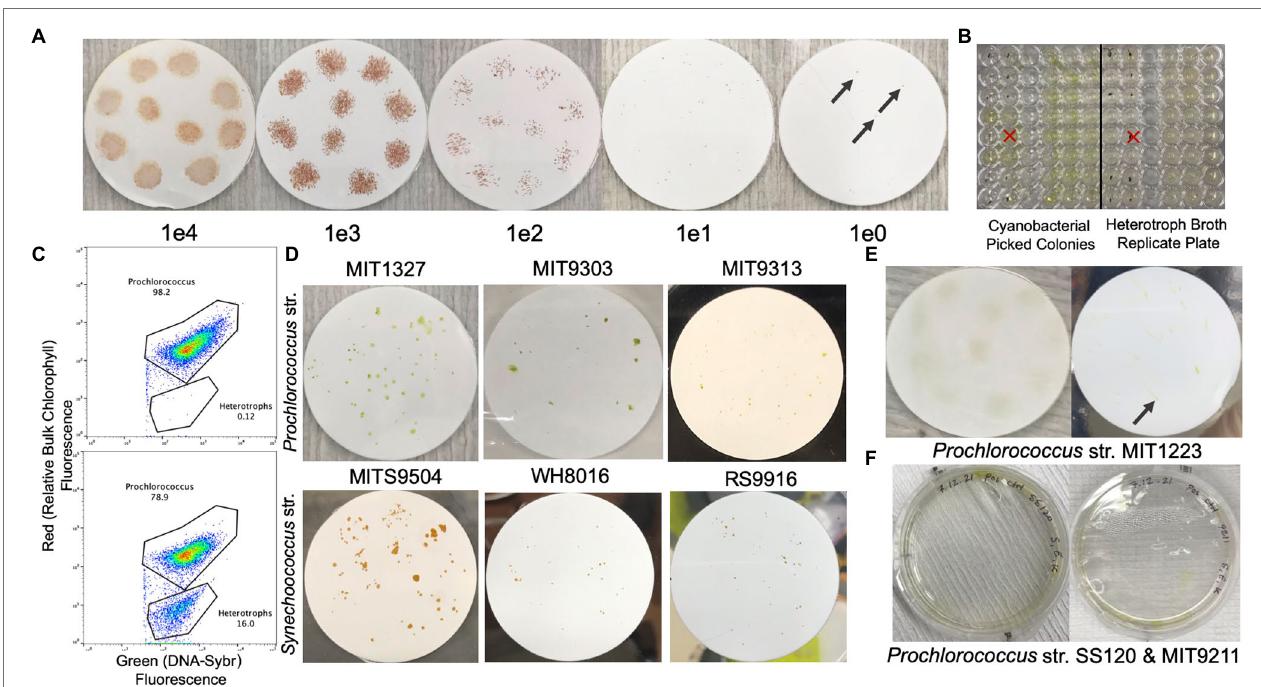
FIGURE 2 | Filter plates with colonial growth of various Prochlorococcus and Synechococcus strains. (A) Dilution series of Synechococcus str. RS9916 on 0.2 μ m Supor filters overlaid on natural seawater-based Pro99 with LMP agarose at 0.3%. Concentrations indicate cells per 10 μ l spot on the filter (black arrows indicate pinpoint colonies). (B) Picocyanobacteria colonies picked into natural seawater-based Pro99 medium (left) and then replicated into MB 2216 Medium to screen for heterotrophs (right, dots on wells indicate contamination). (C) Example flow cytogram of a SYBR Green I DNA stained culture of axenic (top) and non-axenic (bottom) Prochlorococcus . (D) Examples of colonial growth of Prochlorococcus str. MIT1327, MIT9303, MIT9313, and Synechococcus str. MITS9504, WH8016, and RS9916. (E) Diffuse colonial growth of MIT1223 at 1e4 cells per spot (left), and 10 cells per spot (right, black arrow indicates pinpoint colony). (F) Prochlorococcus strains SS120 and MIT9211 with limited/patchy growth in pour plates embedded with helper heterotrophic